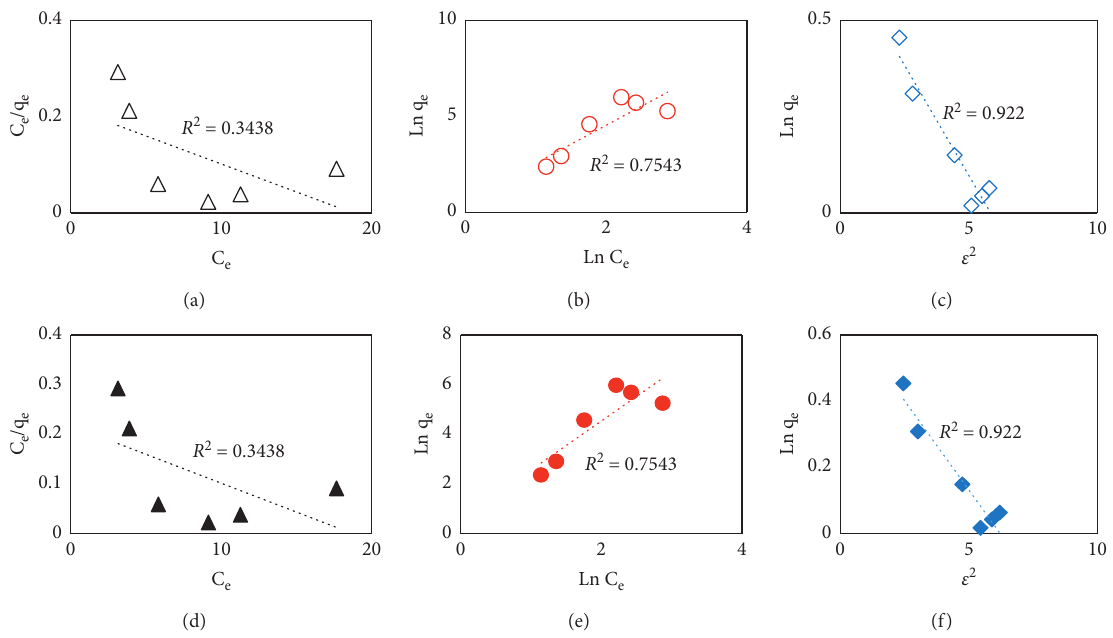
Figure 11: Isotherm models for MR-dye adsorption onto raw (ANb) and purified (ANp) clays. (a) Langmuir, (b) Freundlich, and (c) D-R for ANb; (d) Langmuir, (e) Freundlich, and (f) D-R for ANp. Table 6: Langmuir, Freundlich, and Dubinin-Radushkevich (D-R) parameters. Langmuir Freundlich